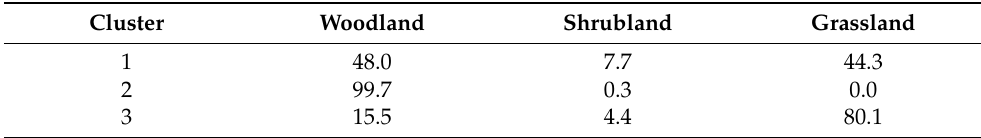
Table 3. Percentages of vegetation type of the selected pixels, based on the National Forest Map. Results for each cluster are based on URF with H2.